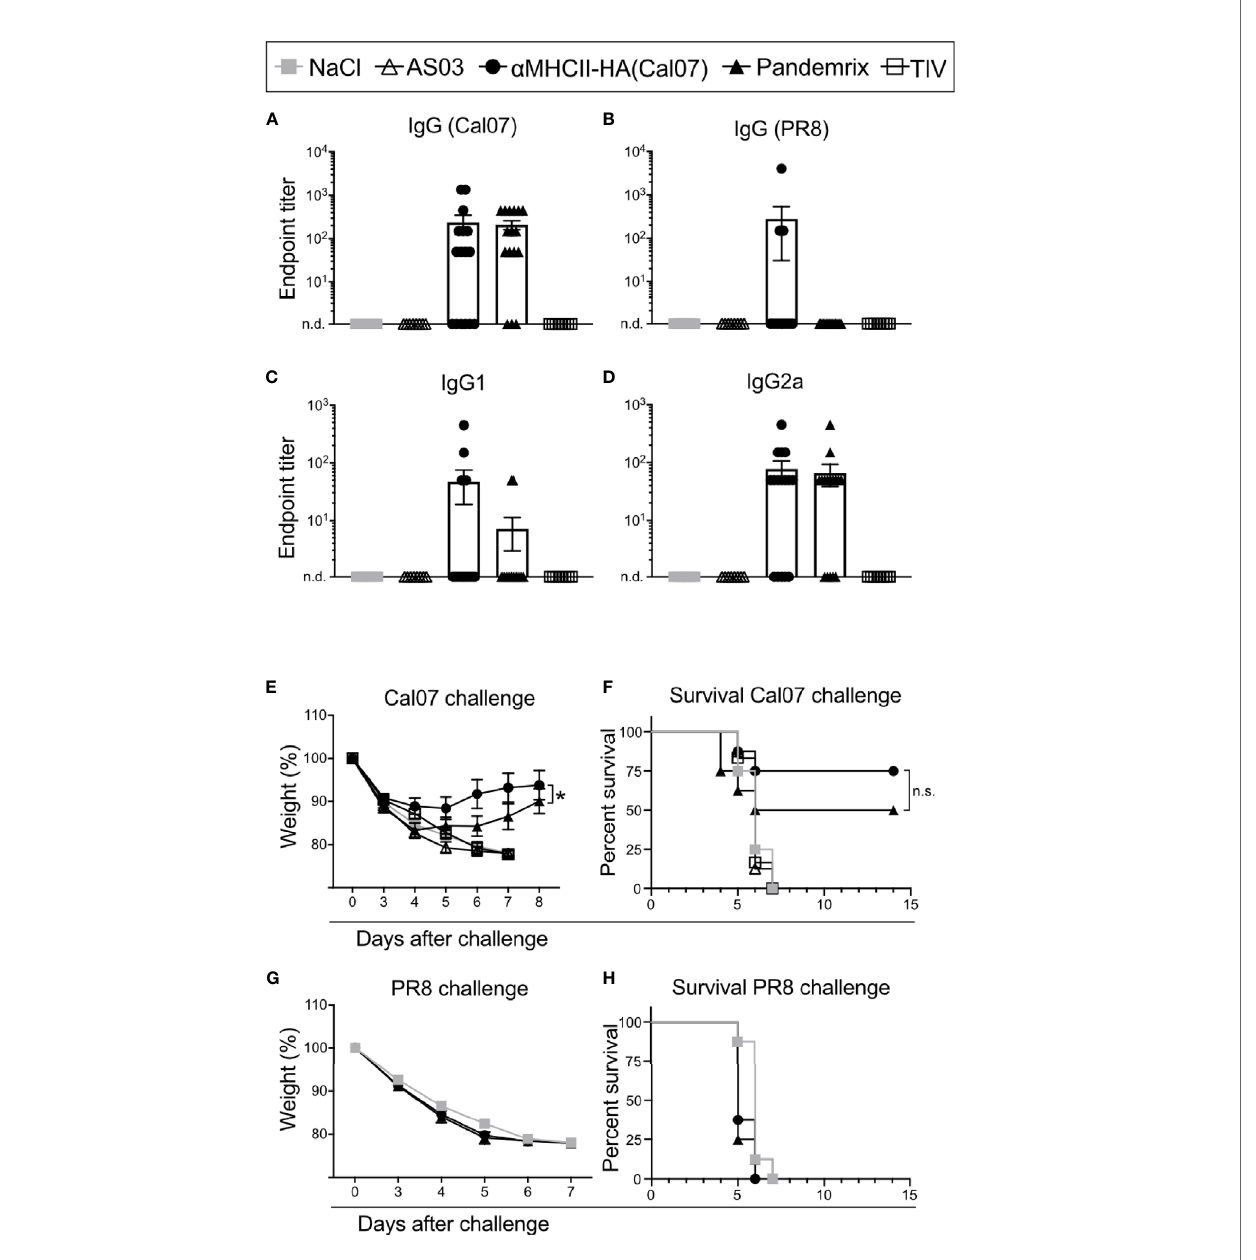
FIGURE 2 | Rapid induction of antibodies and protection after vaccination. Mice were vaccinated i.m. with the indicated vaccines. (A – D) Serum antibodies were monitored at day 7 after vaccination in ELISA for (A) total IgG against HA from Cal07, (B) total IgG against HA from PR8, (C) IgG1 against HA from Cal07, and (D) IgG2a against HA from Cal07. Pandemrix, a MHCII-HA, and NaCl: n=16/group. AS03 and TIV: n=8/group. (E, F) At day 8 after vaccination, mice (n=8/group) were challenged with a 5xLD 50 dose of in fl uenza Cal07. (E) Weight was monitored. (F) Survival curve, as de fi ned by a 20% weight loss. (G, H) At day 8 after vaccination, mice (n=8/group) were challenged with a 5xLD 50 dose of in fl uenza PR8. (G) Weight was monitored. (F) Survival curve, as de fi ned by a 20% weight loss. (A, D, E, G) Data shown are mean ± SEM, *P < 0.05 (two-way ANOVA); (F, H) *P < 0.05 (Gehan-Breslow-Wilcoxon test). n.s., not signi fi